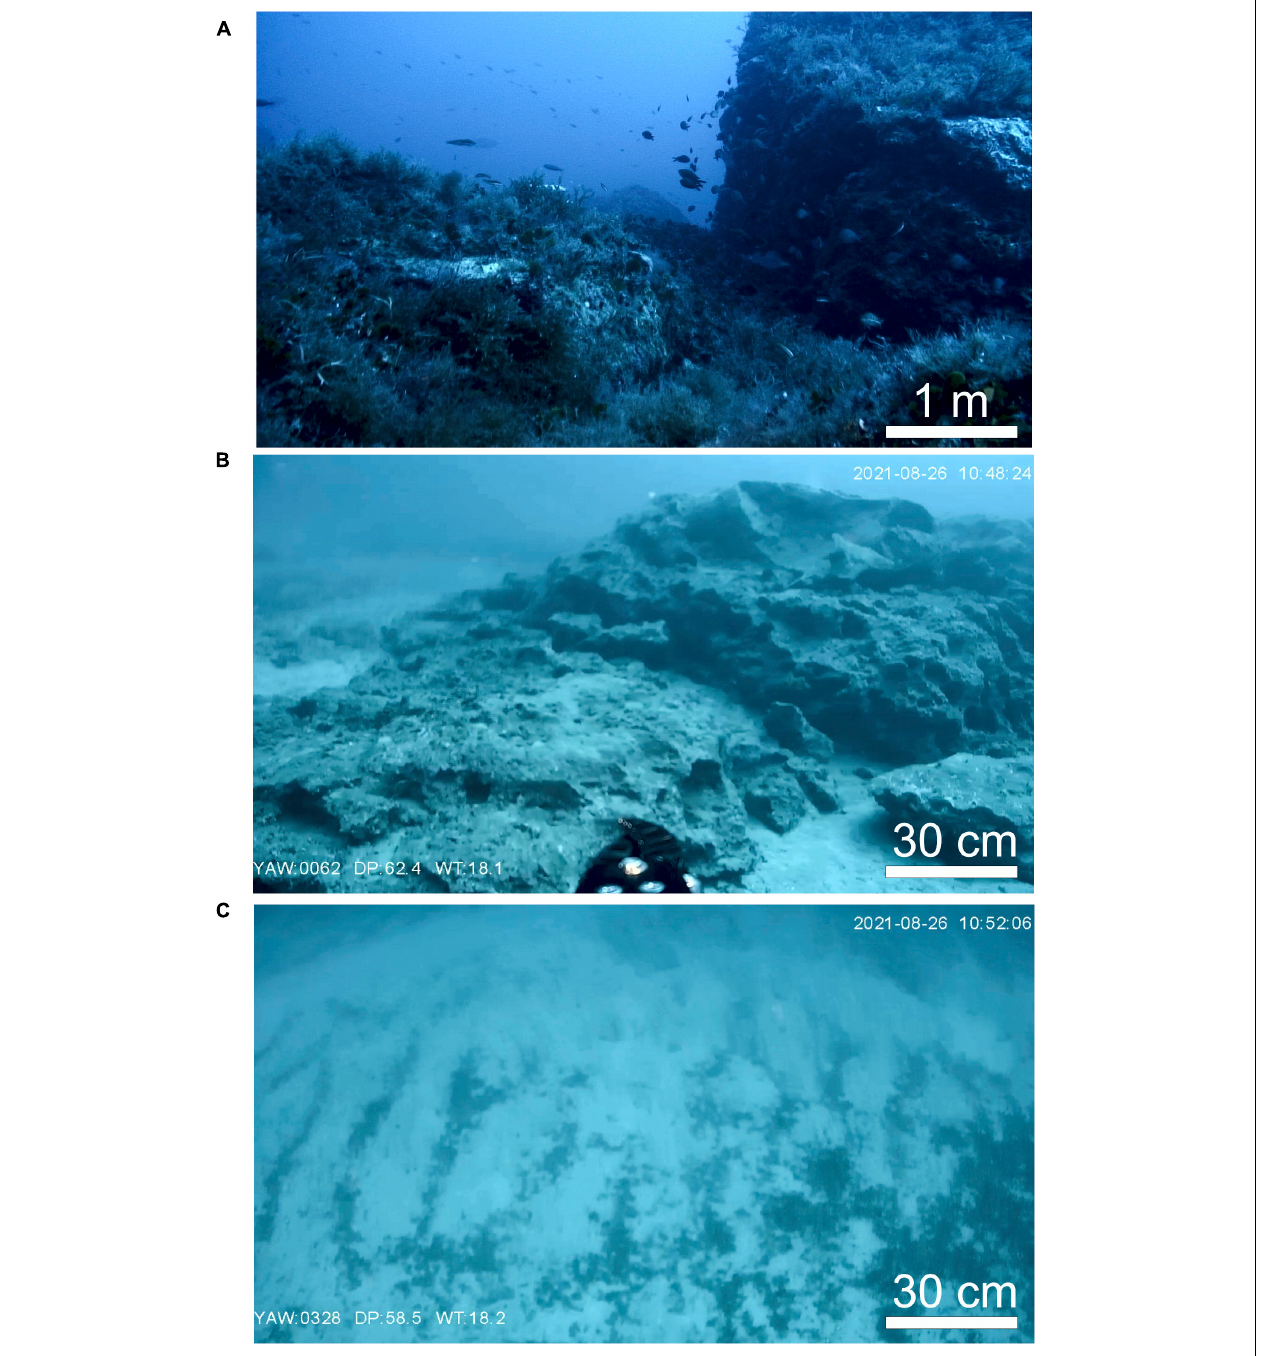
FIGURE 6 | Imagery of mounds from the 40 to 83 m cluster located at 60 mbpsl. (A) Rock outcrops in mounds in the northern part of the study area; (B) rock outcrops in mounds in the southern part of the study area. (C) Sediment ripples adjacent to a mound from the southern part of the study area.